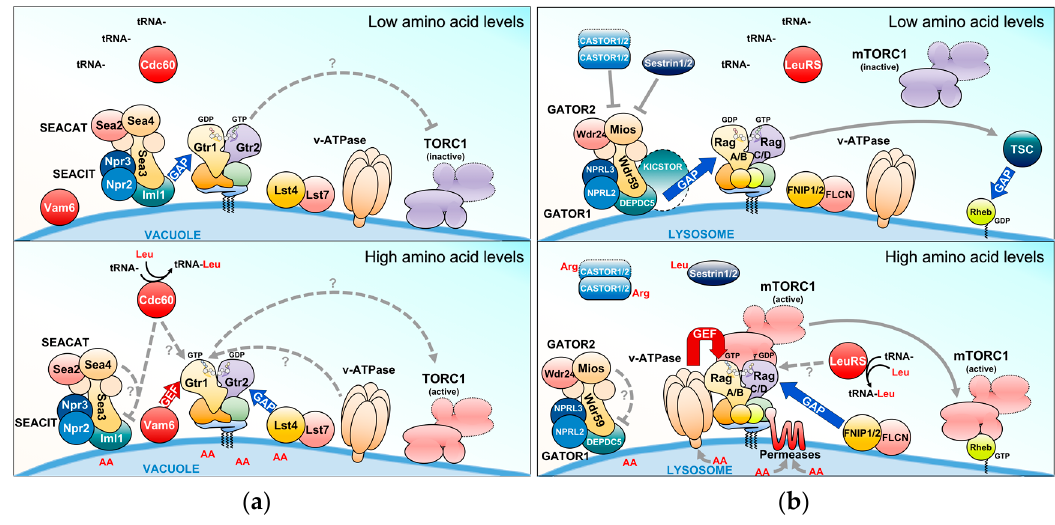
Figure 4. The Rag GTPase signaling network in yeast and mammals. ( a , b ) Upstream regulators that antagonize (when amino acids are limiting; upper panels) or stimulate (when amino acids are abundant; lower panels) the Rag GTPase- target of rapamycin complex 1 (TORC1) signaling branch in yeast ( a ) and mammalian ( b ) cells. Red and blue arrows indicate GTP exchange factors (GEF) and GTPase activating protein (GAP) activities, respectively. Arrows and bars denote activating and inhibiting activities, respectively. Dashed arrows and question marks indicate mechanisms that are currently only partially understood. For further details, see text.